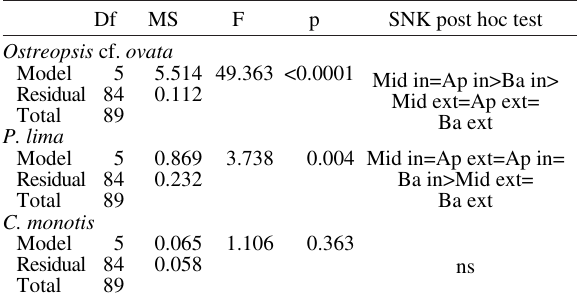
Fig. 5. – Distribution of epibenthic toxic dinoflagellates on the leaf of Posidonia Table 7. – One-way ANOVA result for abundances of epiphytic toxic dinoflagellates on the different parts of P. oceanica leaves, MS, mean square; F, Fisher test; p, significance level; in, inner face; ext, outer face, Ap, apical part of leaf; Ba, basal part; Mid, middle part; SNK, Student-Newman-Keuls; and ns, not significant.